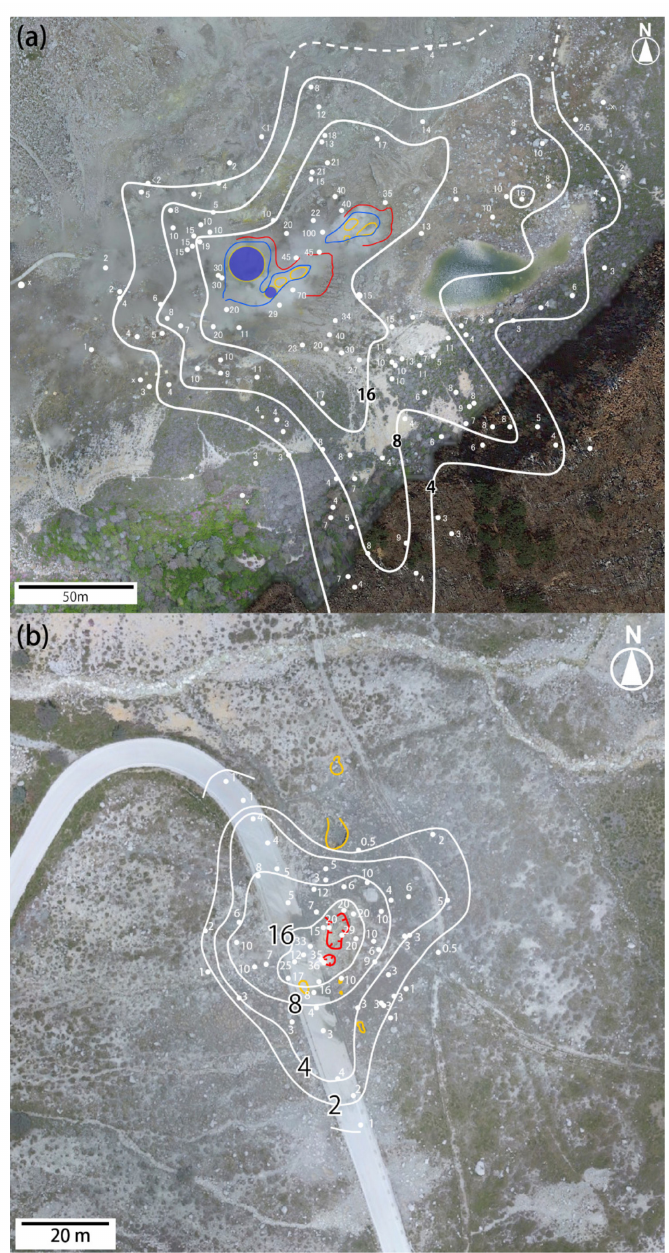
Figure 8. Distribution of ejected blocks and fragments from the Ioyama-south and west craters in April, 2018. ( a ) Block and fragment ejecta distribution from Ioyama-south craters using a drone map on a Google Earth map [45]; ( b ) Block and fragment ejecta distribution from the Ioyama-west crater. The value indicates the size of the diameter in